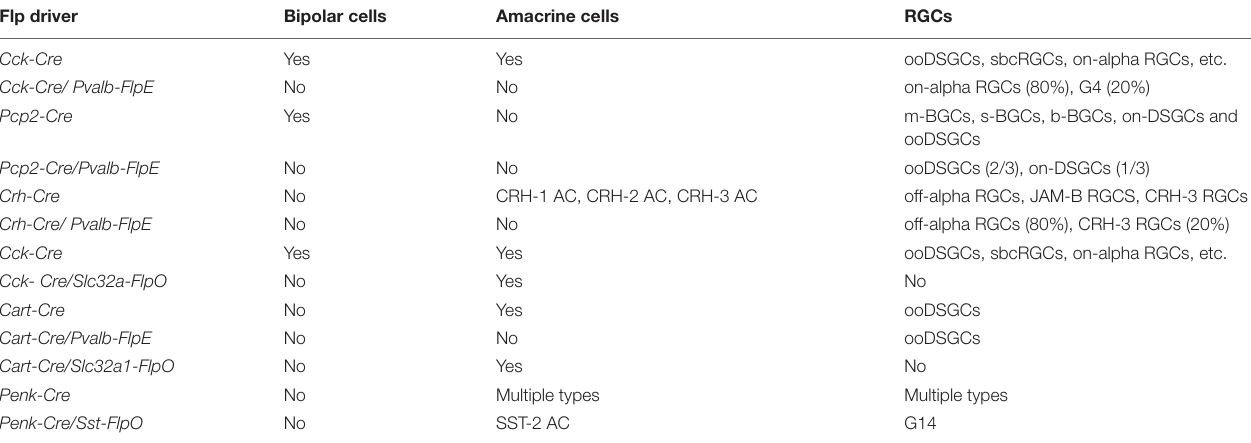
TABLE 3 | Intersectional strategies to restrict retinal cell subpopulations. Flp driver Bipolar